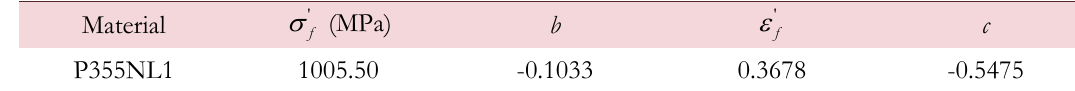
Table 2: Morrow constants for the P355NL1 steel for strain R -ratios, R ε =-1 + R ε =0.